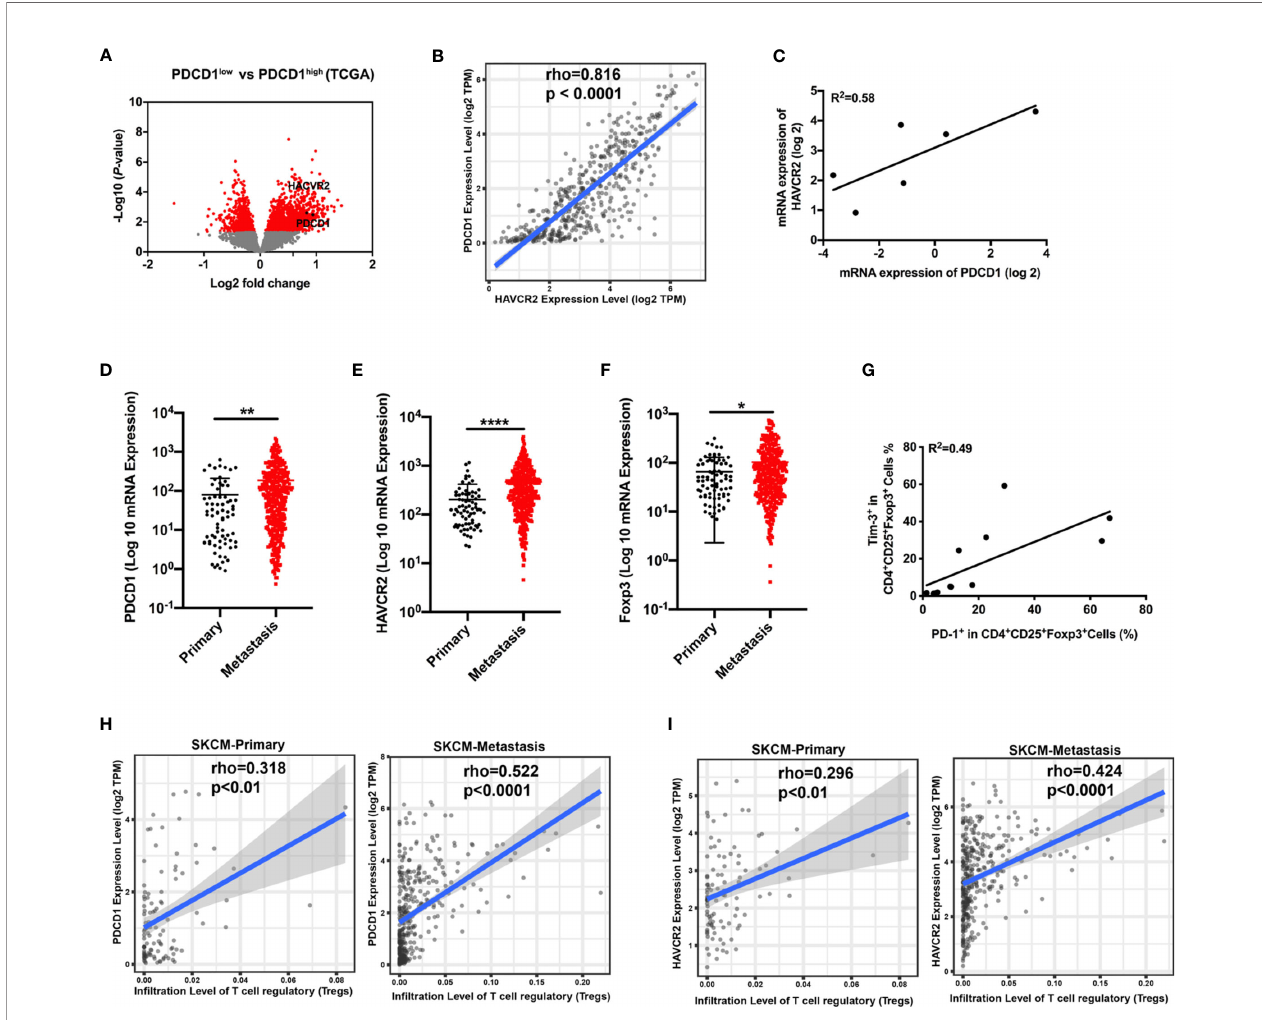
FIGURE 1 | Correlation of PDCD1 expression and HAVCR2 in melanoma. (A) Volcano plot showing enrichment of differentially expressed genes in the PD-1 high and PD-1 low sub-populations from the TCGA dataset (n=472). Signi fi cantly different genes (PDCD1 and HAVCR2) are plotted in black (log2 fold change > 0.5, p < 0.05). (B) Correlation between PDCD1 (PD-1) and HAVCR2 (Tim-3) expression in human melanoma samples from the TCGA dataset (n=472). (C) Association between the mRNA level of PDCD1 (PD-1) and HAVCR2 (Tim-3) from Pearson correlation of melanoma biopsies (n=6; R 2 values by linear regression). (D – F) PDCD1 (D) , HAVCR2 (E) , and Foxp3 (F) expression in primary and metastatic melanoma patients from the TCGA dataset. (G) Relationship of PD-1 and Tim-3 expression on Treg cells in PBMCs from healthy donors (n=9; R 2 values by linear regression). (H, I) Correlation between PDCD1 (H) or HAVCR2 (I) expression and Treg cells in fi ltration in primary and metastasis melanoma patients ’ samples from the TCGA datasets. * p ≤ 0.05, ** p ≤ 0.01, **** p ≤